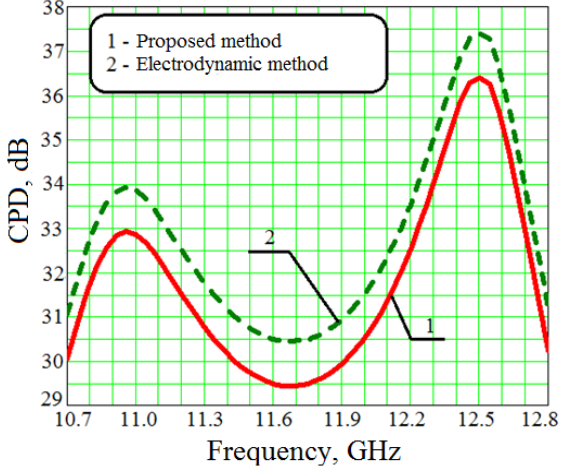
FIGURE 9. CPD vs. frequency for the waveguide polarizer with three